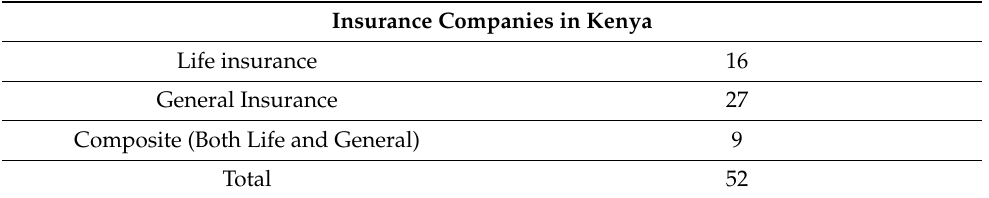
Table 1. Breakdown of the Number Insurance Companies in Kenya, 2009–2018.